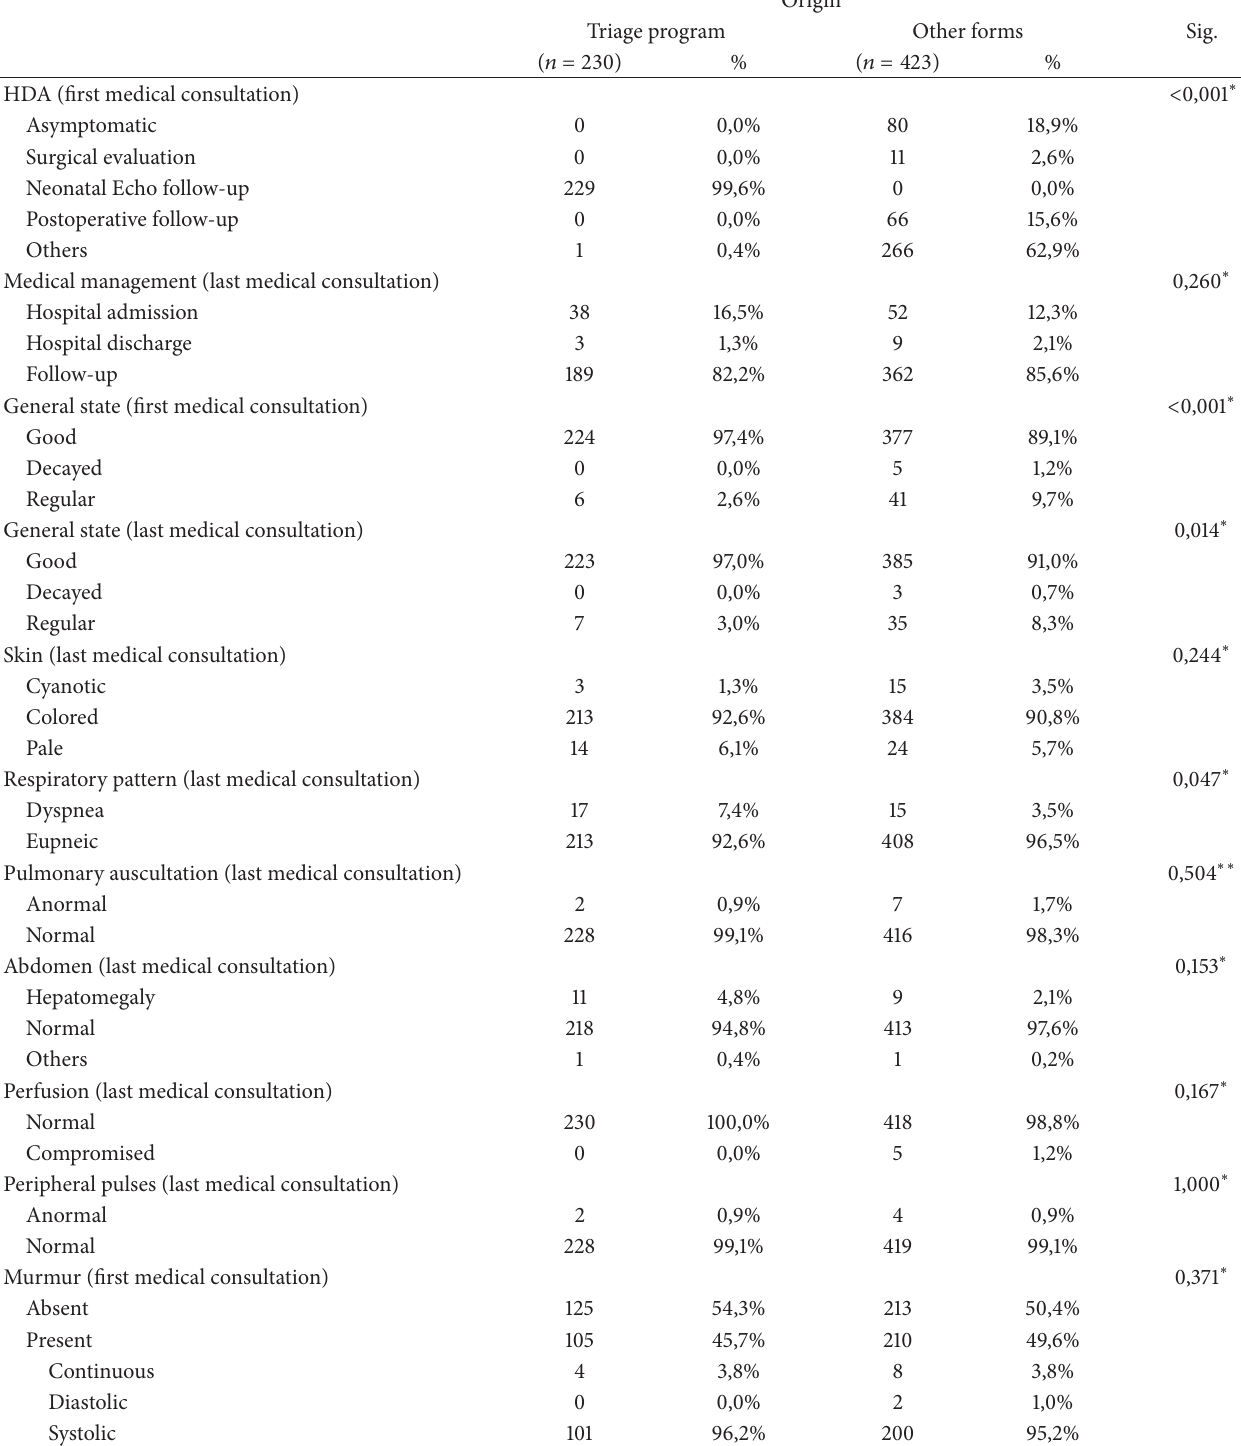
Table 2: Comparison of clinical examination among patients according to mode of access to RCP virtual